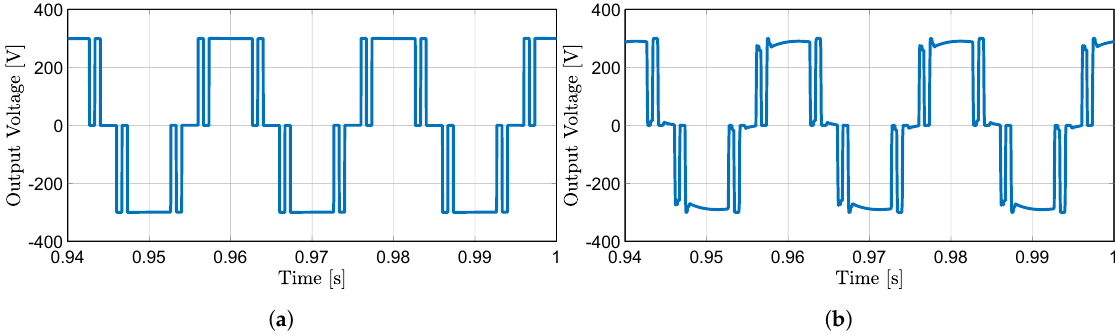
Figure 6. ( a ) The inverter output voltage (No load); ( b ) The load voltage when motor is connected.